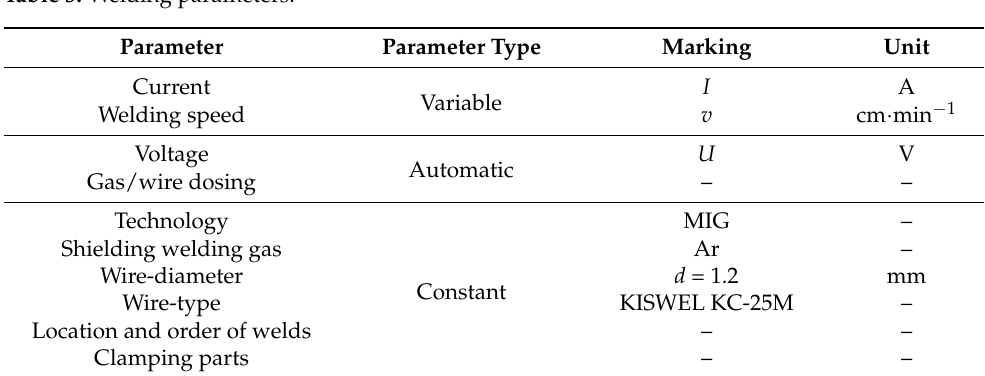
Table 3. Welding parameters.